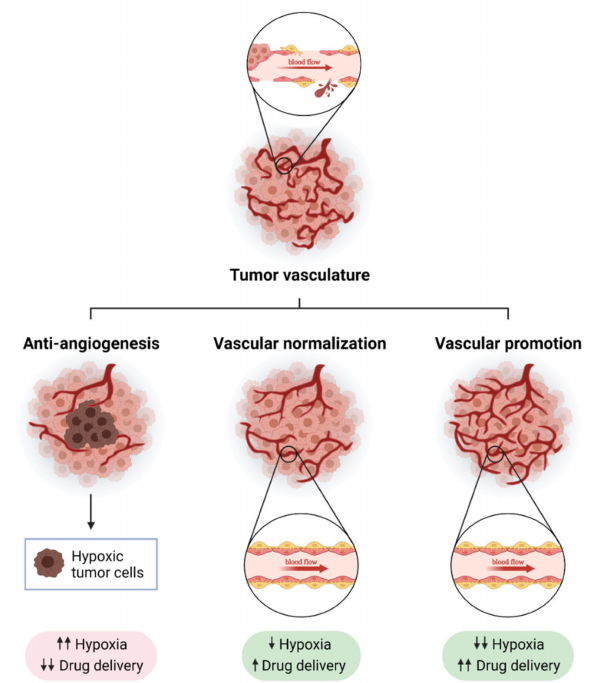
Figure 1. Strategies to modulate tumor blood vessels to enhance cancer therapy efficacy . Tumor blood vessels are immature, leaky and show a disorganized structure, which causes hypoxia and immunosuppression ( upper panel ). The modulation of tumor vasculature can enhance anti-tumor strategies. Anti-angiogenesis consists of the inhibition of molecular pathways involved in the promotion of the formation of new blood vessels from pre-existing ones (like VEGF-VEGFR axis, Ang2, or endoglin). A strong reduction in blood vessel density after anti-angiogenic treatment leads to increased tumor hypoxia and poor drug delivery ( bottom left panel ). Normalizing tumor vasculature can overcome some of the limitations of anti-angiogenic therapy: blood flow is increased, which improves drug delivery, and tumors become more oxygenated ( bottom middle panel ). In recent years, a new strategy called “vascular promotion” has been developed using low doses of α v β 3 integrin inhibitors or other molecules such as LPA (lysophosphatidic acid). In contrast to vascular normalization, vascular promotion increases the number of blood vessels promoting an increase in blood flow, and drug delivery and a reduction in tumor hypoxia ( bottom right panel ). Created with BioRender.com, accessed on 17 October